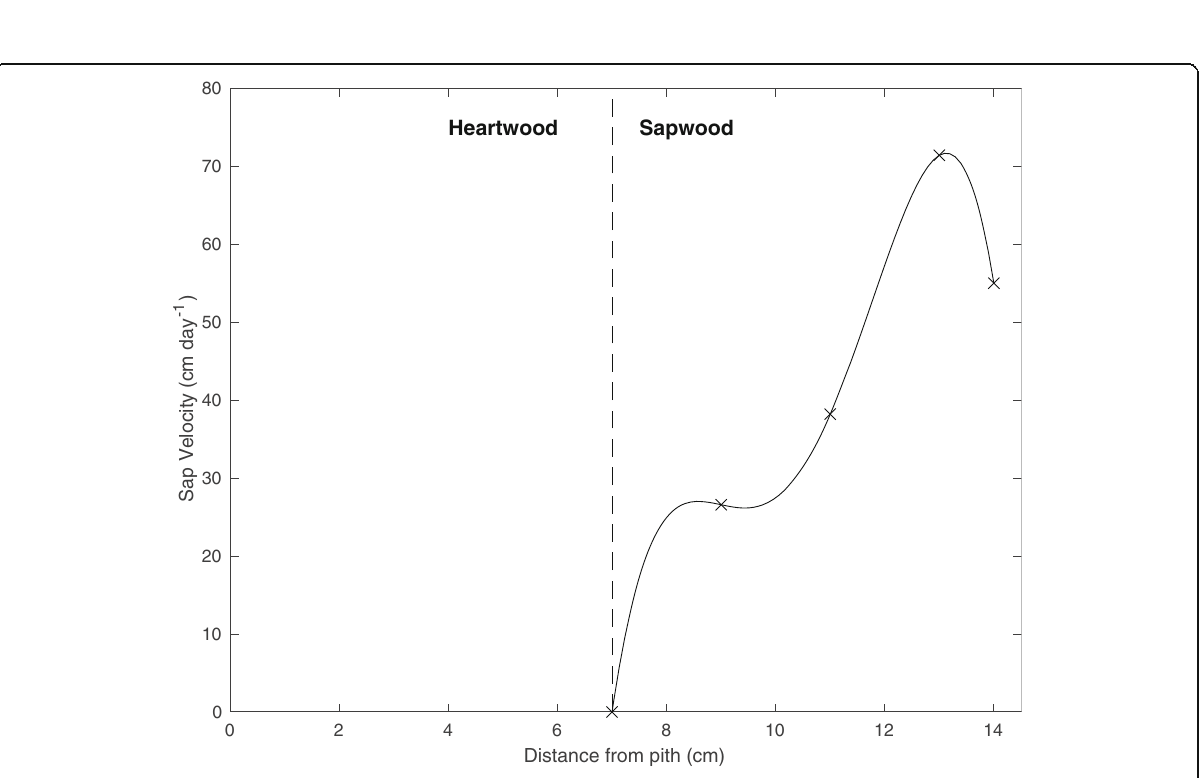
Fig. 4 Daily mean sap velocity at varying depth from the pith. On average, the heartwood extends approximately 7 cm from the pith. At 7 cm, the sapwood begins and extends to 14 cm where it reaches the edge of the